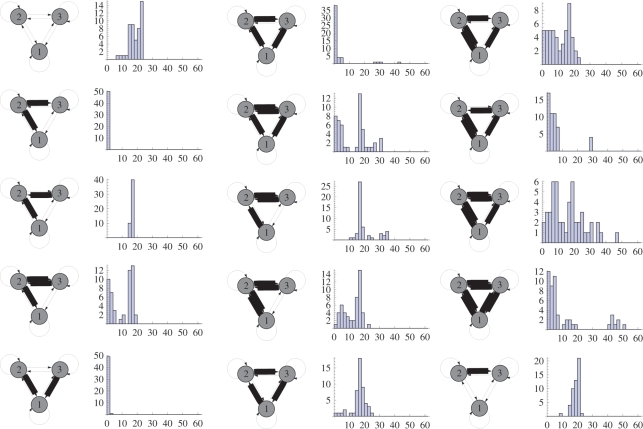
The 15 parental motifs are shown on the left of the histogram of the distribution of Euclidean distances of 40 offspring from itself.A Euclidean distance of 30 corresponds to a total weight difference equivalent to one maximal weight (30 mV).